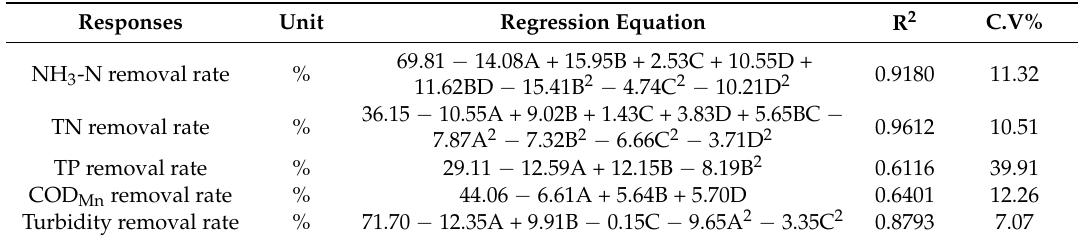
Table 5. Regression model of various pollutants removal